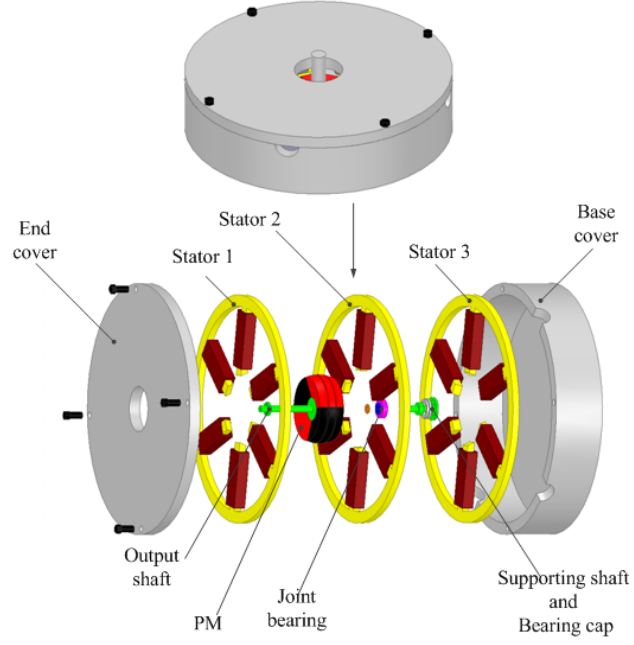
Figure 1. Permanent magnet rotor deflection type three-degree-of-freedom (3-DOF)motor model.